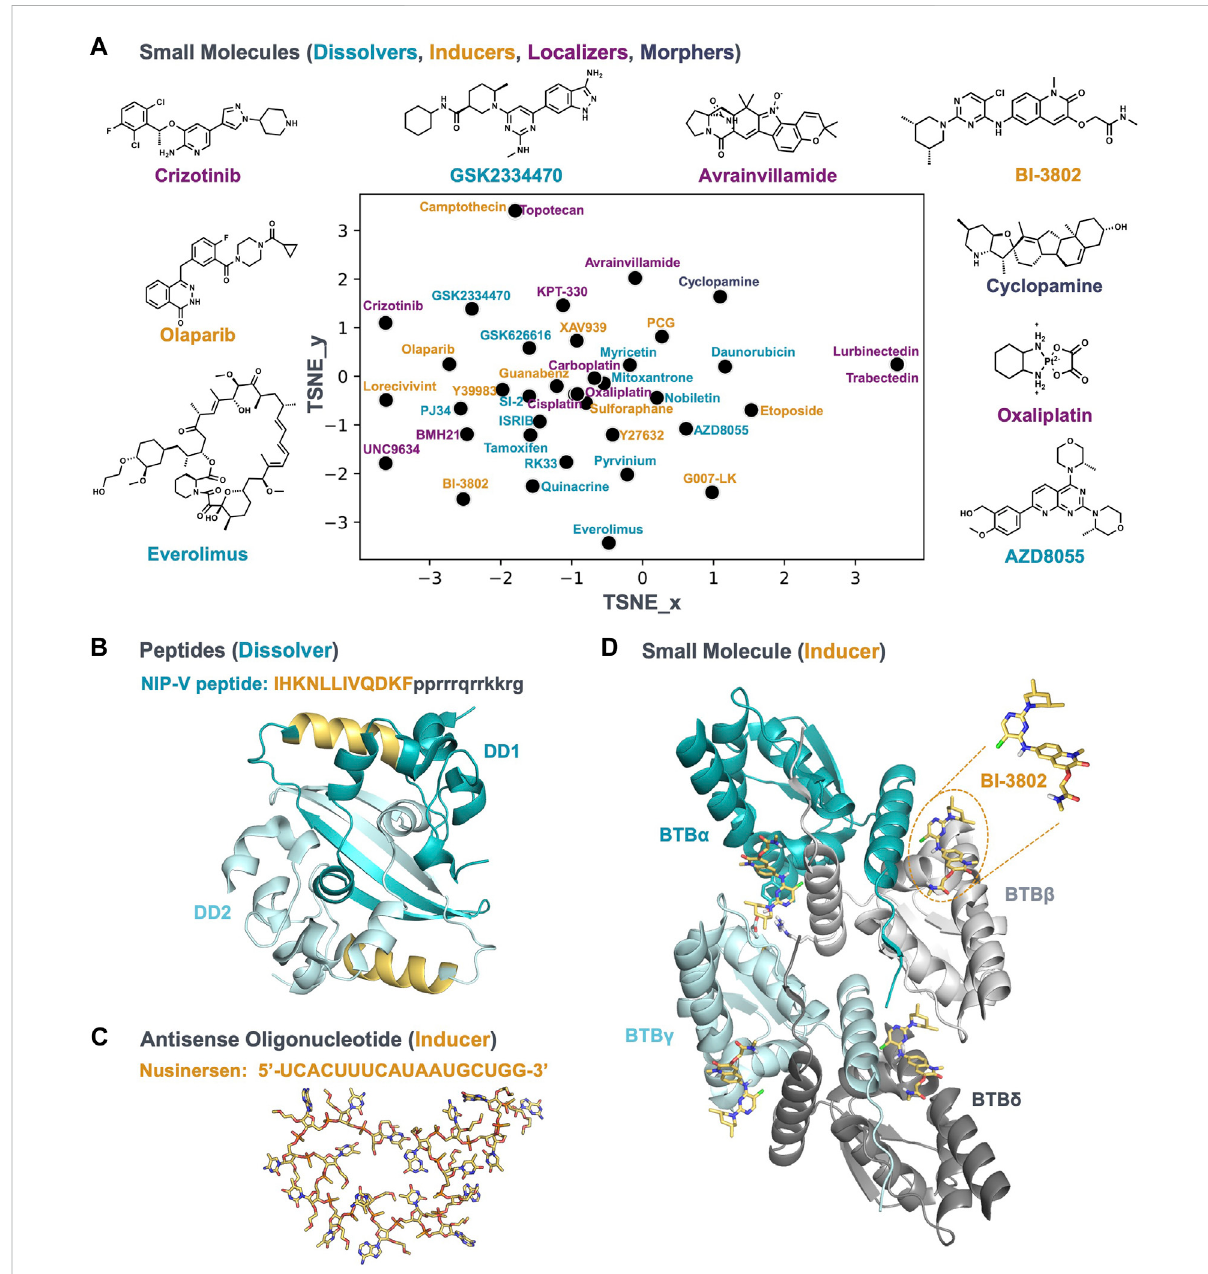
FIGURE 2 Achemicallydiversesetofbioactivemoleculesactasc-mods. (A) Thedefaultt-SNEprojectionofsmallmoleculesbyapplyingrdkit fi ngerprints; the molecules are reported in Table 1; the molecule names are colored according to the c-mod classes shown in Figure 1. The 2D structure of representative small molecules are shown. (B) A representative of the dissolver c-mod class, The NIP-V peptide sequence (gold) binds to the dimerization domain (DD) oftheSARS2-NP (PDBID: 7C22), A Tat-fusion (in black) wasincluded inNIP-V to facilitate cellular uptake. (C) and (D) Representatives of the inducer c-mod class. (C) Nusinersen ASO structure, downloaded from PubChem, was energy minimized and the